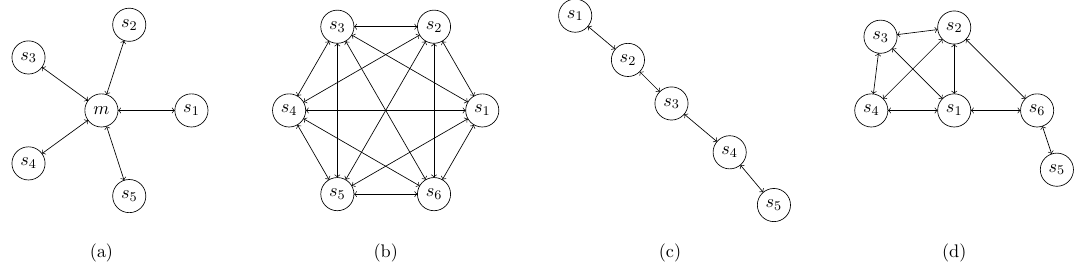
Figure 7. Satellite network topologies: ( a ) Star; ( b ) fully connected; ( c ) line; and ( d )